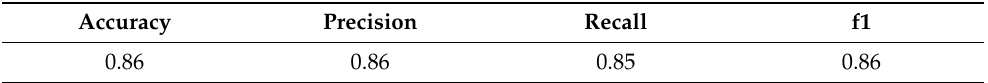
Table 5. Results obtained by the model trained on data from 28th April to 9th May with parameters presented in Table 4 and validated on data from 10th May to 11th